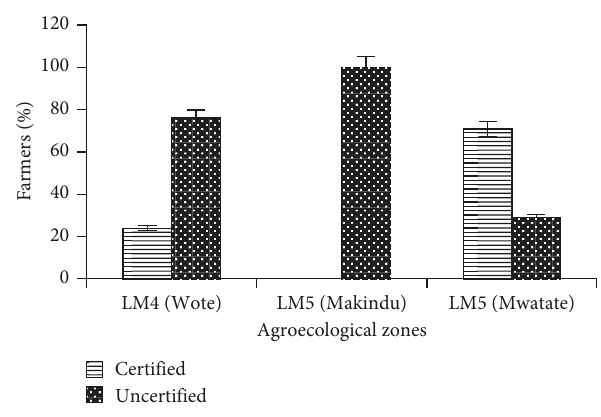
Figure 1: Percentage of farmers using certified and uncertified cowpea seeds in various AEZ in Makueni and Taita Taveta counties during the 2016 short